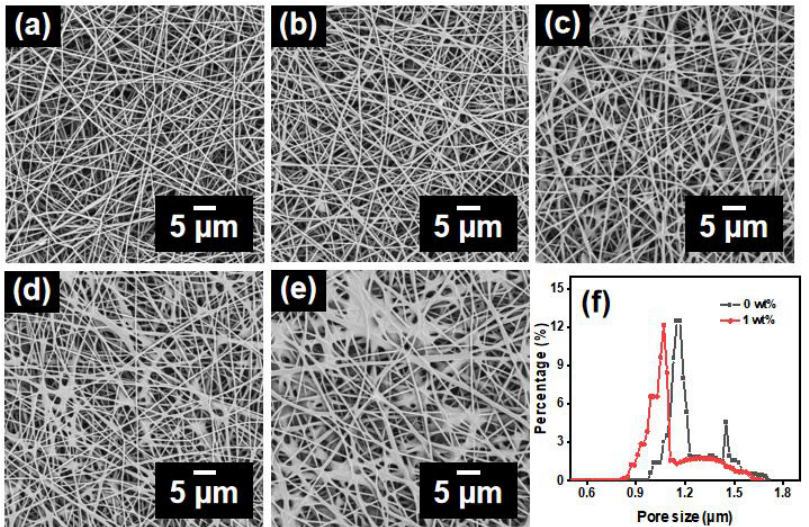
Figure 2. SEM images of hydrophobically-modified PAN@AMP membranes with different concen- trations of AMP: ( a ) 0, ( b ) 0.5, ( c ) 1, ( d ) 2 and ( e ) 4 wt%. ( f ) Pore size distribution of PAN original membranes and PAN@AMP-1 membranes.